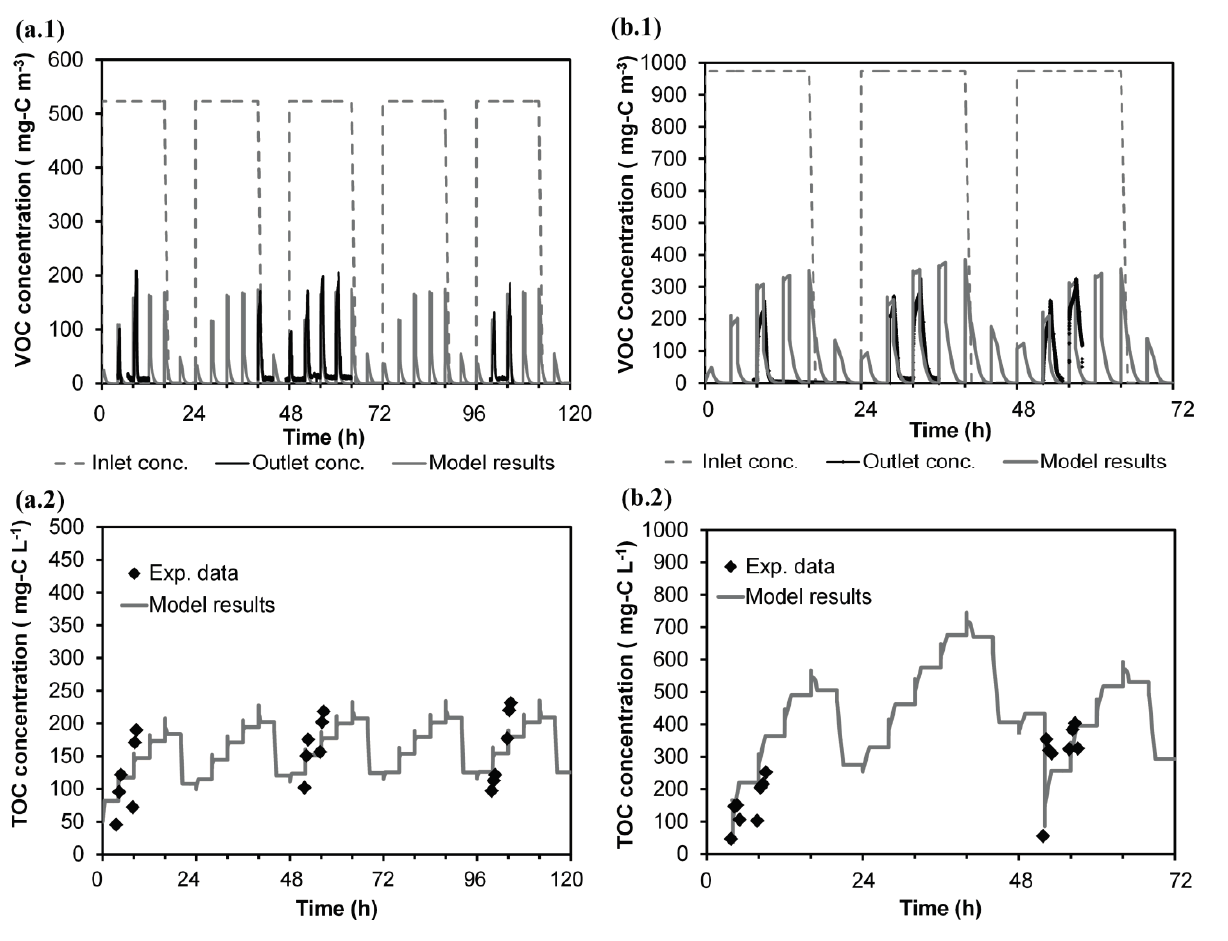
Figure 5. Weekly evolution of the experimental data and model predictions for the treatment of isopropanol by BTF ( a ) Run 2. ( a.1 ) gas phase; ( a.2 ) dissolved carbon in the water tank. ( b ) Run 3. ( b.1 ) gas phase; ( b.2 ) dissolved carbon in the water